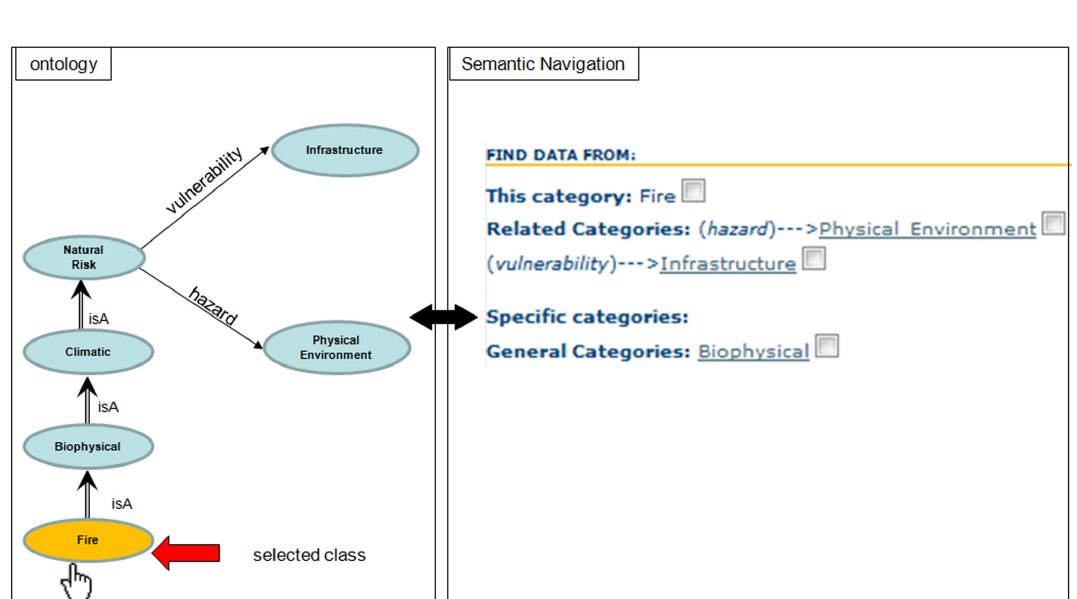
Fig. 8. Semantic navigation in